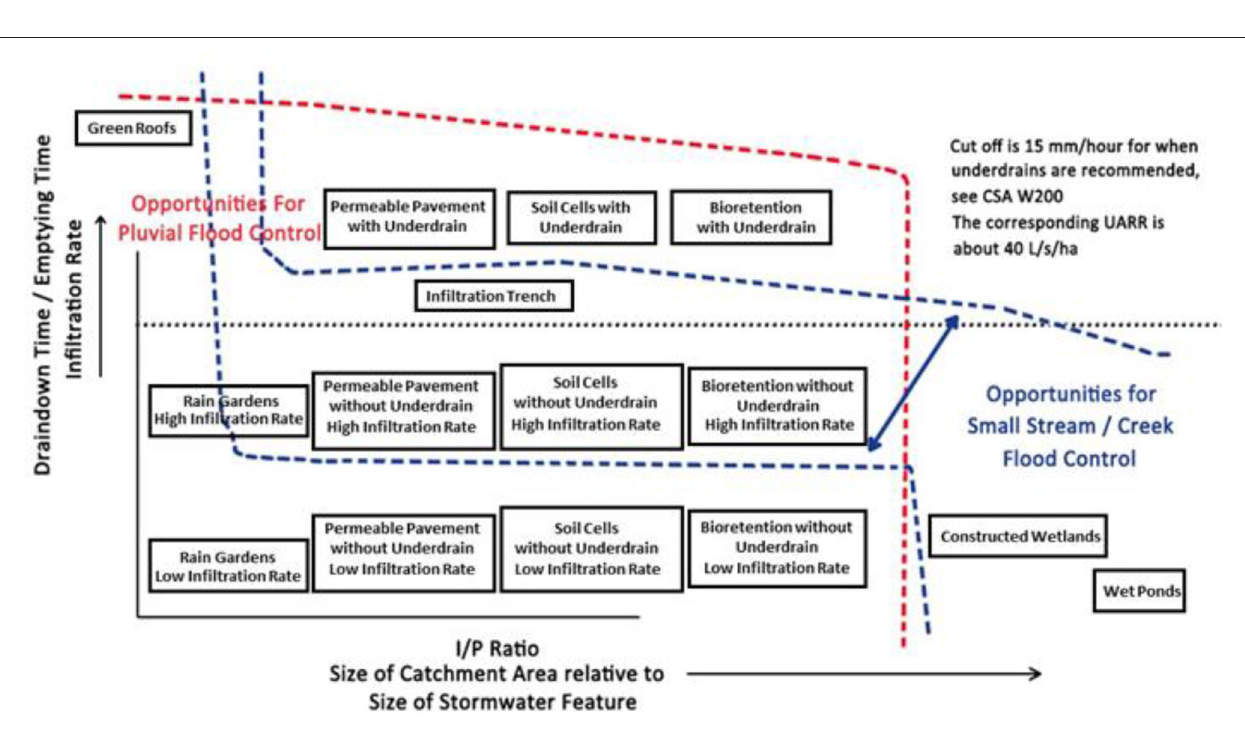
movement during extreme storm events, thus jeopardizing infrastructure and structures adjacent to them. Retention